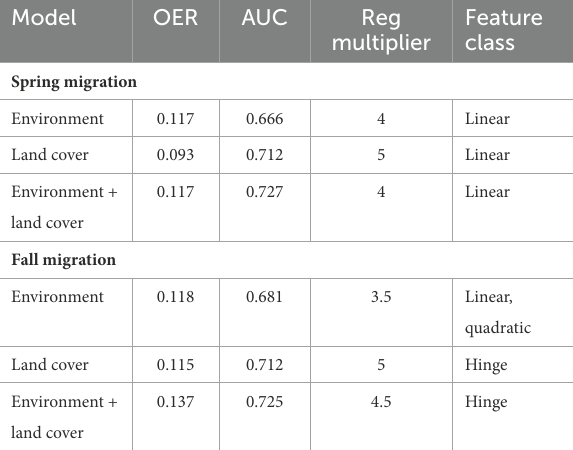
TABLE 2 Parameter settings and model fit for the final species distribution models using environment, land cover, and environment + land cover variables.